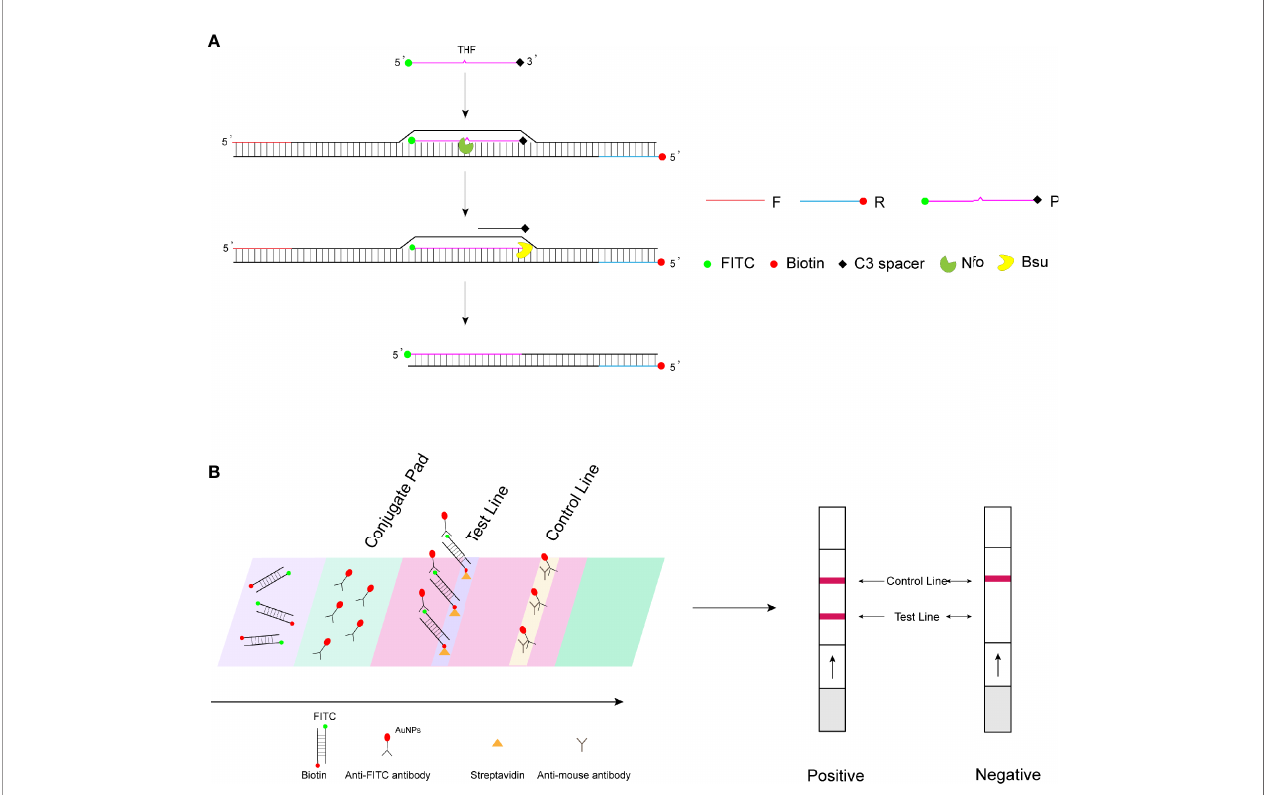
FIGURE 1 | RPA-LFS detection mechanism diagram. (A) Principles of RPA ampli fi cation. (B) Visualization of lateral fl ow test